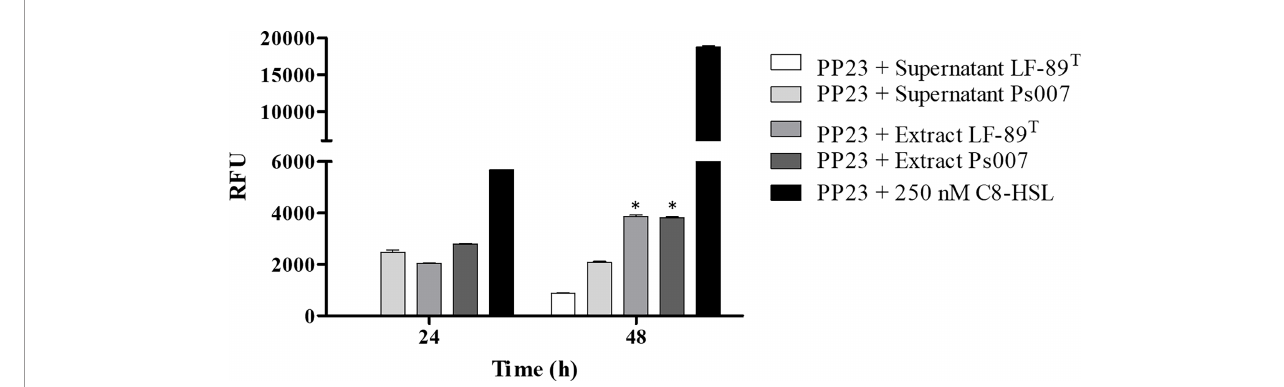
FIGURE 3 | Fluorescence induction in P. putida EL 106 (RPL4cep) of supernatants and organic extracts of P. salmonis at different times. The fi ltered supernatant and organic extracts (dissolved in 10% w/v ASB) of each P. salmonis strain were arranged in a 1:1 ratio with the bacterial biosensor P. putida EL106 (RPL4cep) (10 9 cells/mL). Samples and controls were incubated for 24 and 48 h at 27°C. PP23: P. putida EL 106 (RPL4cep); Controls: P. putida EL106 (RPL4cep) (10 9 cells/mL) + 250 nM C8-HSL. Emitted fl uorescence was recorded in a microtiter plate reader at 515 nm. RFU, relative fl uorescence units. Asterisks indicate statistical signi fi cance (ANOVA P ≤ 0.01, n = 3) between the supernatant and the organic extracts. Error bars: standard